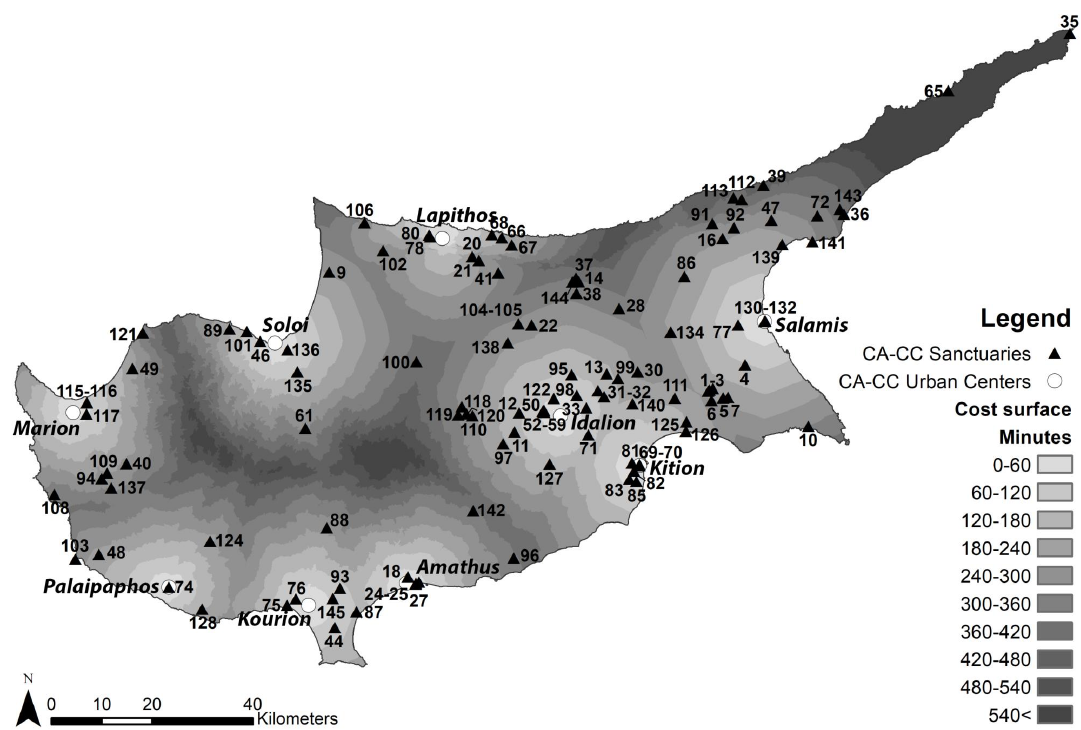
Figure 2. Hypothetical map showing the synchronicity of Cypriot kingdoms (as independent polities) and sanctuary sites at the transition from the Archaic to the Classical period, illustrating the problems involved in an attempt to capture political and sacred landscapes at a single point in time during the Iron Age (cost surface GIS analyses conducted by converting slope inclinations derived from the DLS DEM to time cost per unit surface area travelled based on exponential anisotropic Tobler’s hiking function). Sanctuary numbers on the map correspond with site names published in the online appendix of (Papantoniou 2013b): www.ajaonline.org/article/1493; accessed on 17 December 2021. Digital data courtesy of the Department of Geological Survey and the Department of Lands and Surveys (map and analysis by Charalampos